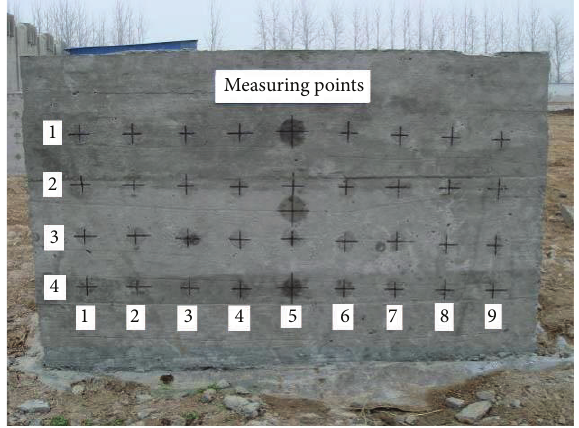
Figure 2: Measuring points of longitudinal wave velocity on concrete